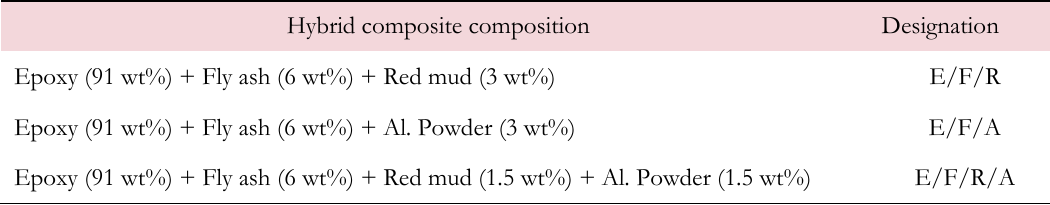
Table 7: The hybrid composites